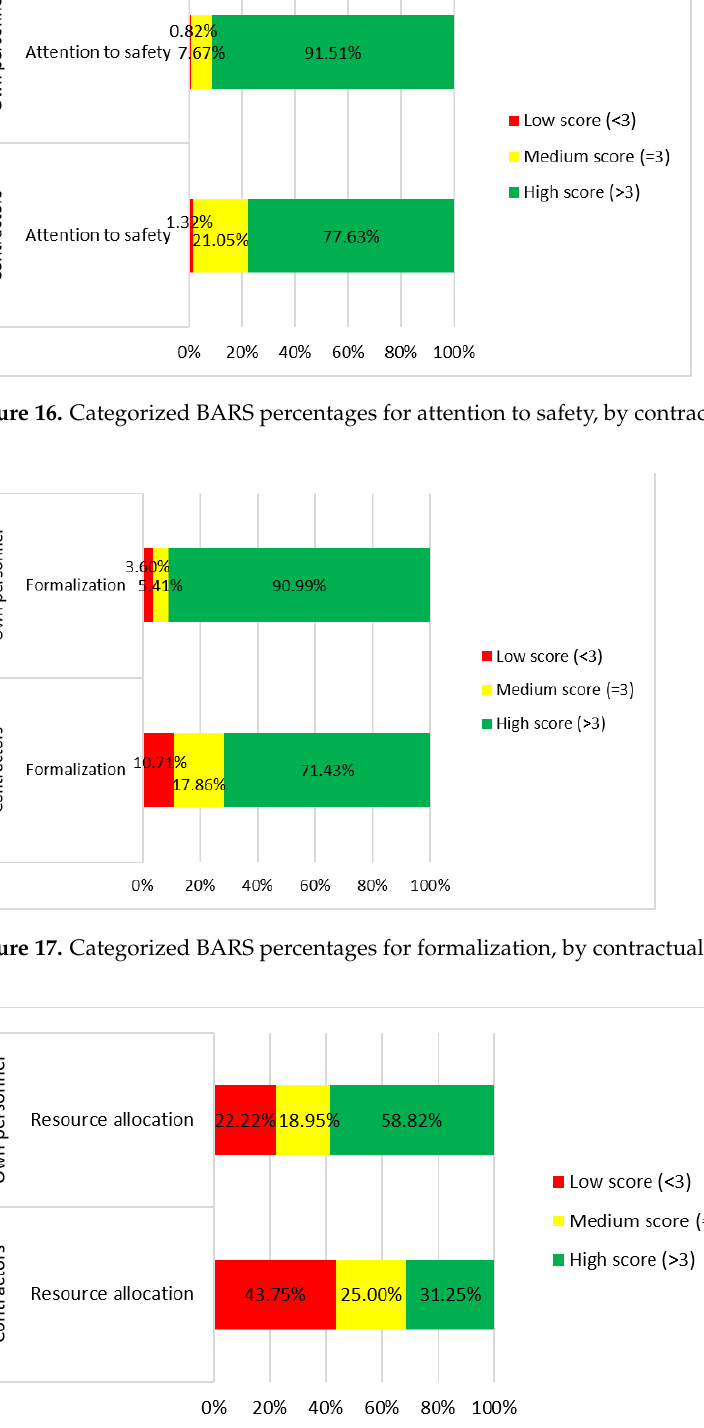
Figure 18. Categorized BARS percentages for resources allocation, by contractual relationship.